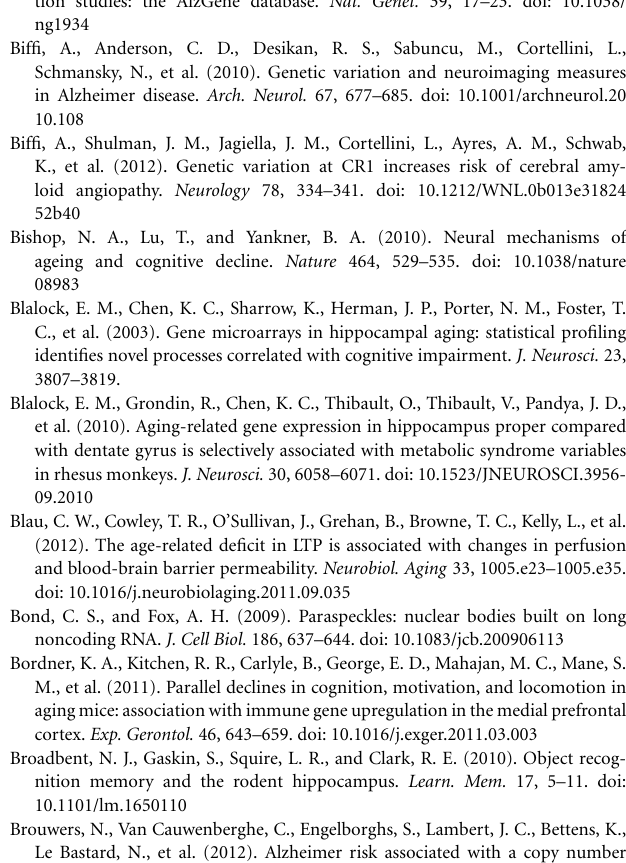
Figure S1 | Immunohistochemical analysis of hippocampal cell number. (A) Representative images showing immunostaining for the Neuronal maker protein Neuronal N (NeuN), the Microglia marker Ionized calcium binding adaptor molecule 1 (IBA1) and the astrocyte marker Glial fibrillary acidic protein ( GFAP) in 3 and 29-month old mice. (B) Quantification of A. CA1; hippocampal subregion CA1, cc; corpus calosum. Scale bar: 100 μ m. Figure S2 | Functionally enriched pathway in 3 vs. 24 and 29 month old mice identified on the basis of gene array data. Left panel : Enriched pathways identified on the basis of differentially expressed genes comparing hippocampal RNA from 3- vs. 24-month-old mice. Right panel : Enriched pathways identified on the basis of differentially expressed genes comparing hippocampal RNA from 3 vs. 29-month-old mice. Figure S3 | Genetic architecture and domain structure of Sptbn1. The figure was downloaded from the ENSEMBLE database (version e76). It shows the genomic locus of Sptbn1 and its annotated transcribed isoforms including exon structure and encoded protein domains. Isoform 2 is marked in yellow. This was the isoform that is likely underlying the switch in exon usage detected in RNA-seq data in 24M and 29M